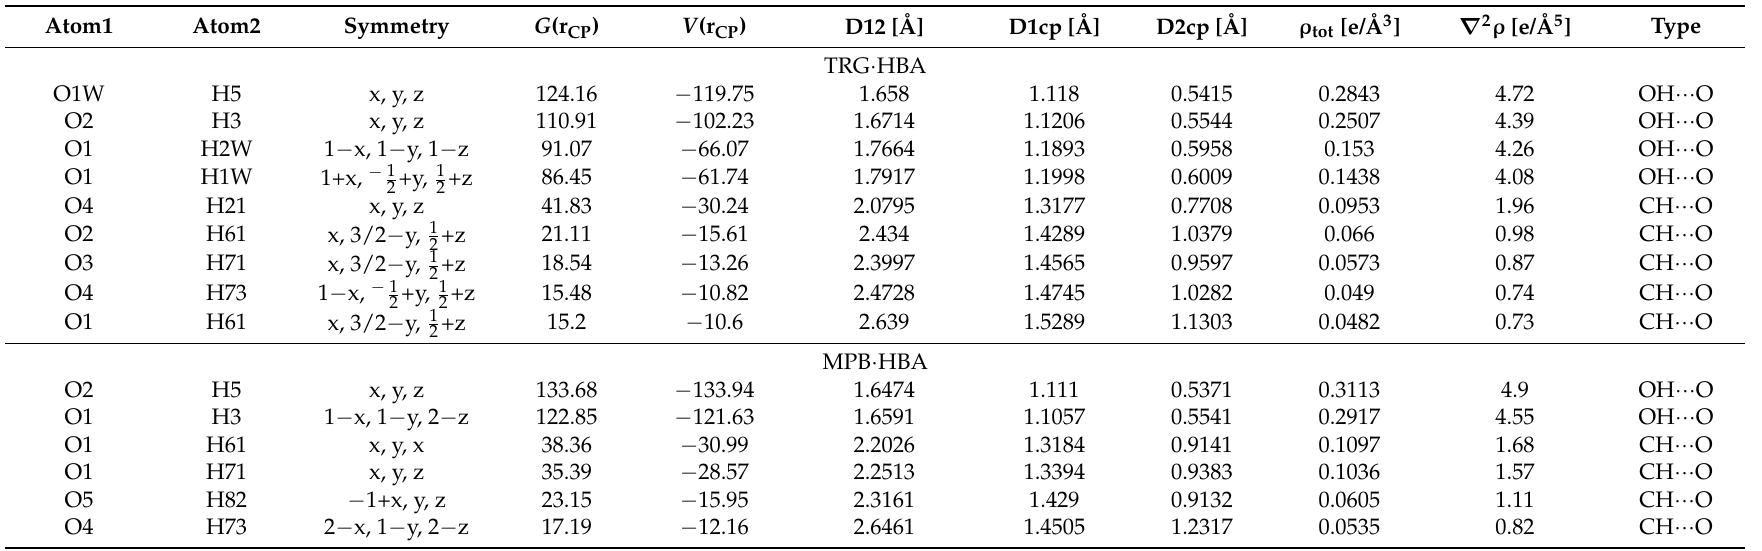
Table 2. Distances and topological characteristic of the bond critical points (BCPs) in 1 and 2 .